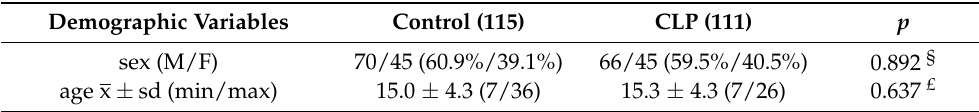
Table 2. Demographic statistics for the sample studied.